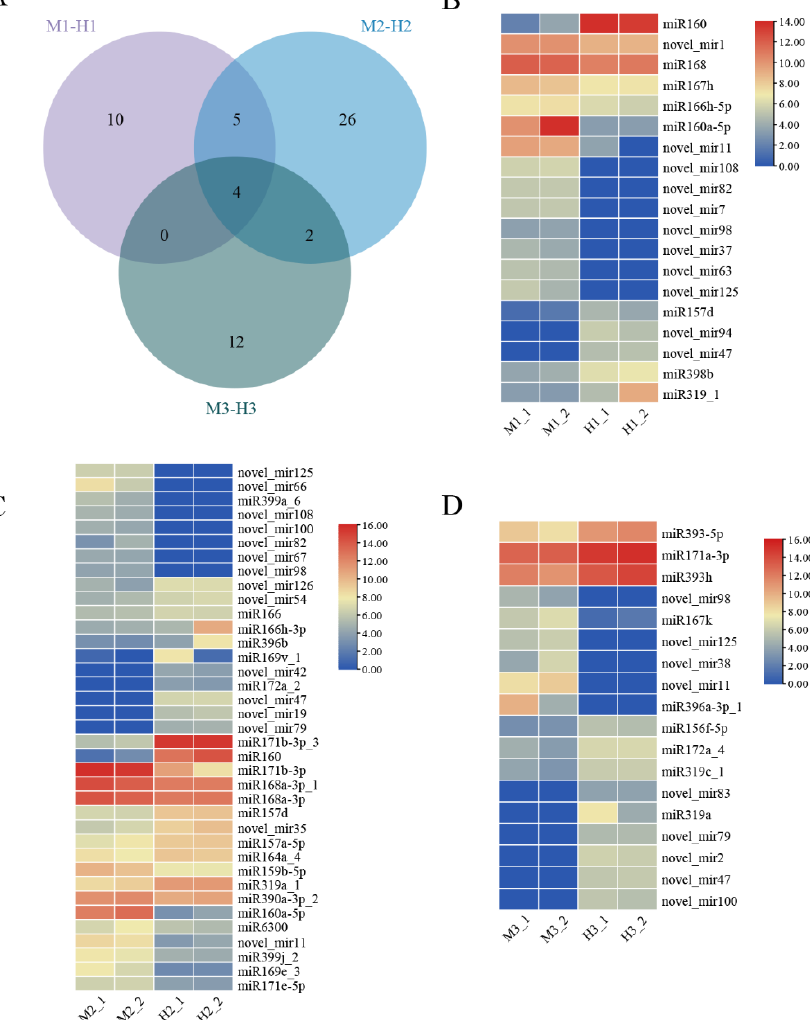
Figure 3. Venn diagram and heat maps of miRNAs differentially expressed in males and hermaphrodites at three stages. ( A ) Venn diagram of differentially expressed miRNAs at three stages. ( B ) Heat map of differentially expressed miRNAs in the first stage (M1-H1). ( C ) Heat map of differentially expressed miRNAs in the second stage (M2-H2). ( D ) Heat map of differentially expressed miRNAs in the third stage